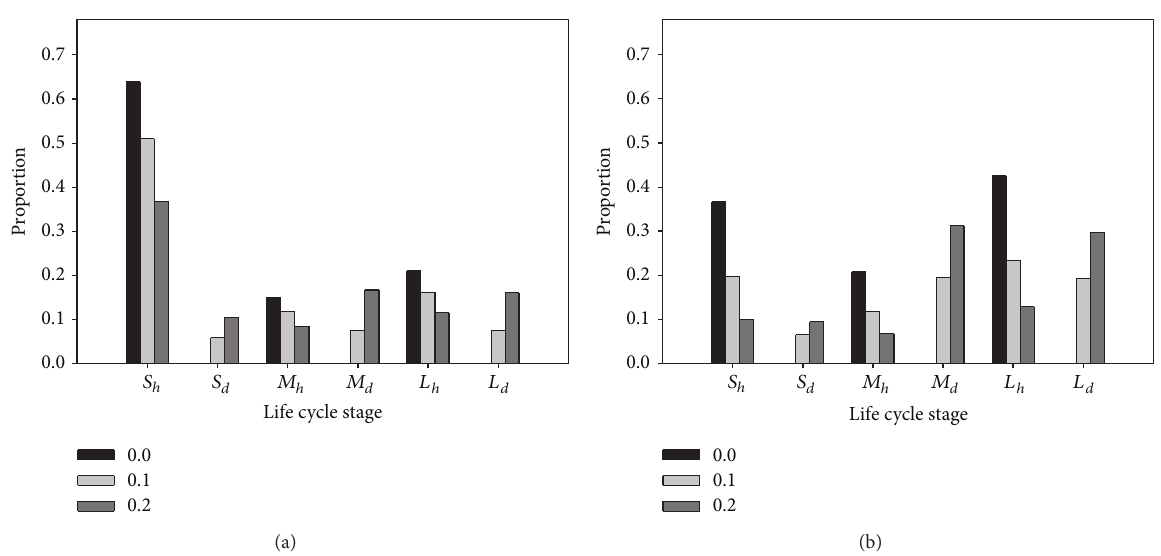
Figure 2: Stable stage distribution of Gorgonia ventalina colonies of three size classes (small ( 𝑆 ), medium ( 𝑀 ), and large ( 𝐿 )) and two health states (healthy ( ℎ ) and diseased ( 𝑑 )) for three levels of disease incidence (0, 0.10, and 0.20) under (a) high and (b) low